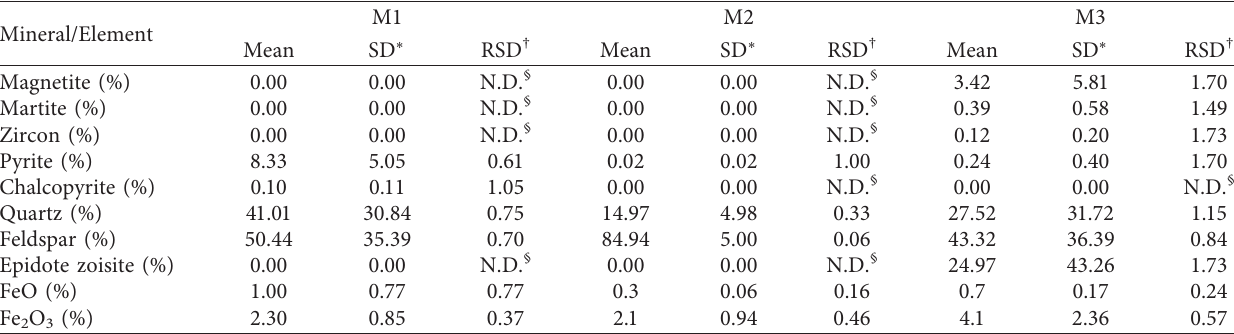
Table 1: The main mineralogical compounds that were measured in laboratory. The standard deviation (sd) and the relative standard deviation (rsd) were also included to examine the variance in the mineralogical measurements. Mineral/Element Magnetite (%)